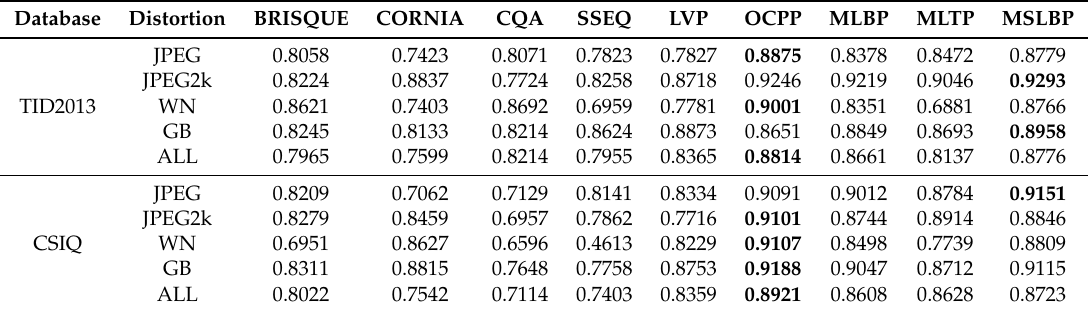
Table 8. SROCC cross-database validation, when models are trained on LIVE2 and tested on CSIQ and